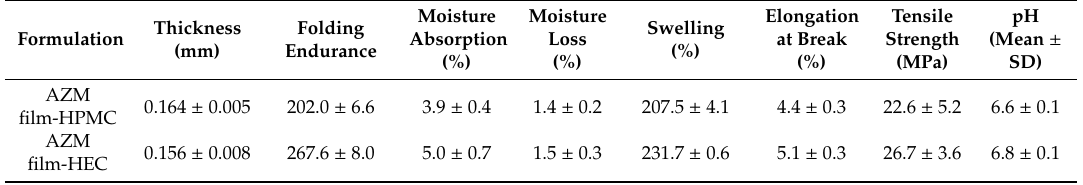
Table 3. Physicochemical parameters of the ocular inserts of azithromycin (mean ± SD, n = 3). Thickness Folding Formulation (mm)